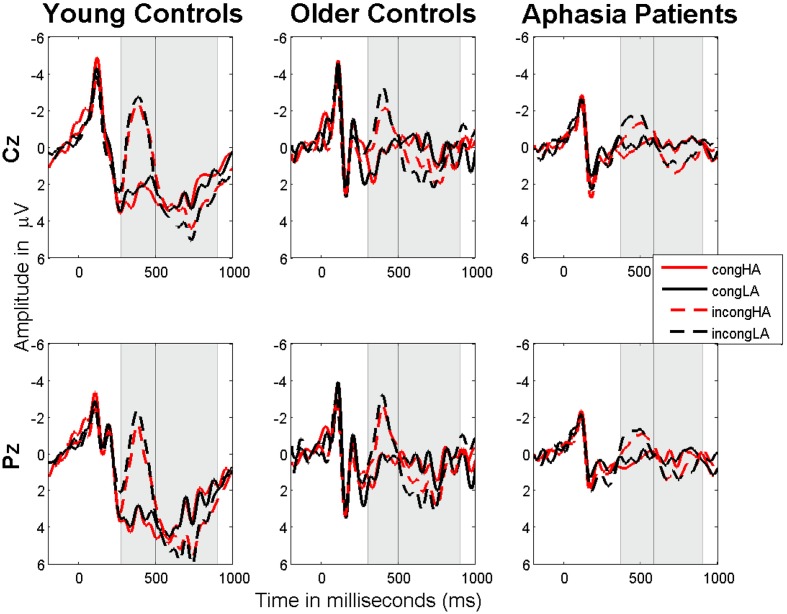
N400 and P600 potentials on central electrodes Cz and Pz for each subject group (young healthy controls, older healthy controls, and aphasia patients). The gray shaded areas represent the statistically significant differences between sentence groups. Negative voltages are plotted upward. The decrease in N400 amplitude in older control subjects and patients compared to the young control group and the increase in N400 onset latency in the patients compared to both control groups are observed.